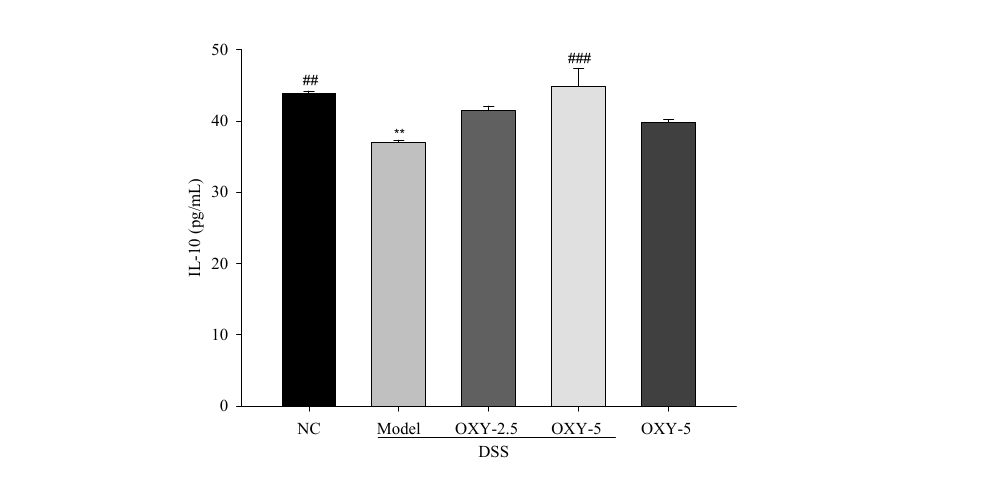
Figure 6. Effect of OXY on IL-10 levels in serum ( n = 8/group). Anti-inflammatory cytokine IL-10